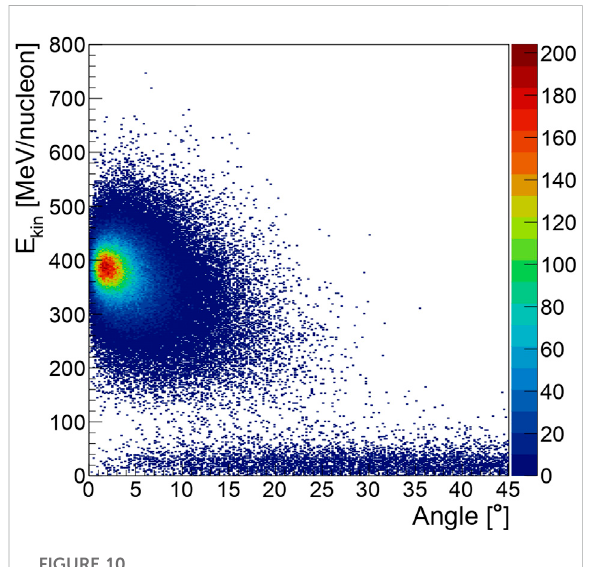
FIGURE 10 MC simulation: Production kinetic energy of He fragments versus their production angle. The contribution of the isotropic lowenergytargetHefragmentsisclearlyvisibleandwellseparated from the Helium ions coming from the projectile fragmentation.